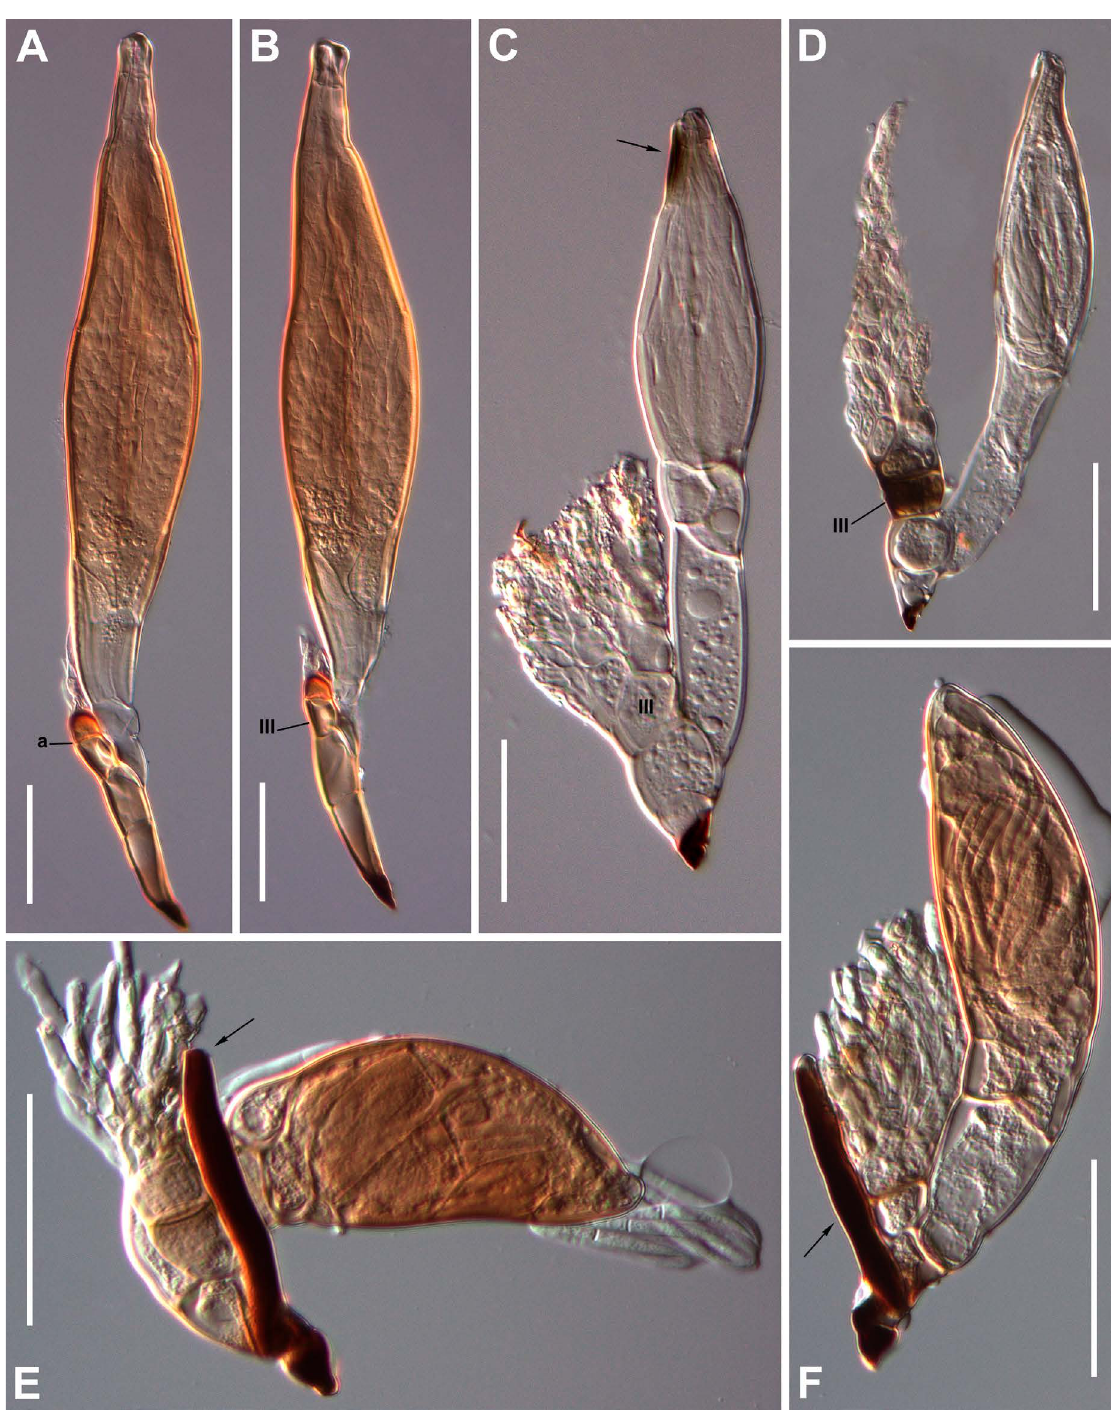
Fig. 47. Corethromyces spp. – A – B . C. bialowiezensis T.Majewski. Mature thalli, with labelled primary septum (a) and cell III. – C – D . C. henrotii Balazuc ex Balazuc. C . Typical mature thallus showing cell III and shaded preapical region with a dark spot on the perithecial posterior side (arrow). D . Mature thallus of a unusual form having a darkened cell III. – E – F . C. stilici Thaxt. Mature thalli from abdominal tergites (E) or sternites (F), both showing a labelled cell I blackened outgrowth (arrows). Scale bars: 50 µm. Photographs from slides ZMUC C-F-124370 (A–B), ZMUC C-F-124127 (C), ZMUC C-F-124125 (D), ZMUC C-F-122735